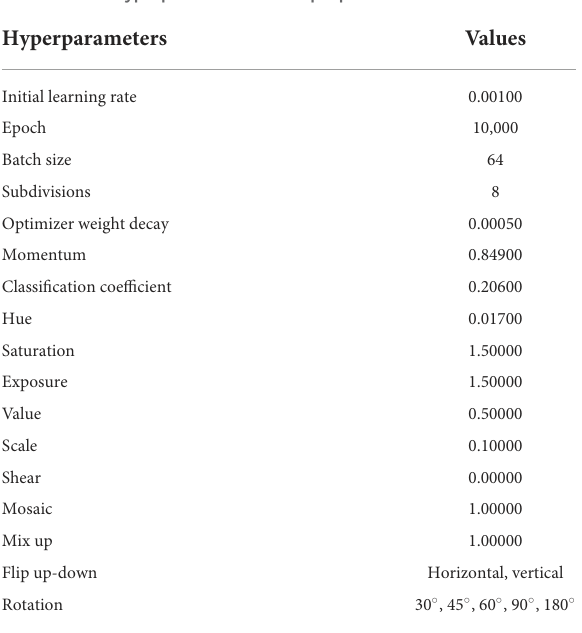
TABLE 3 The hyperparameters of the proposed model.